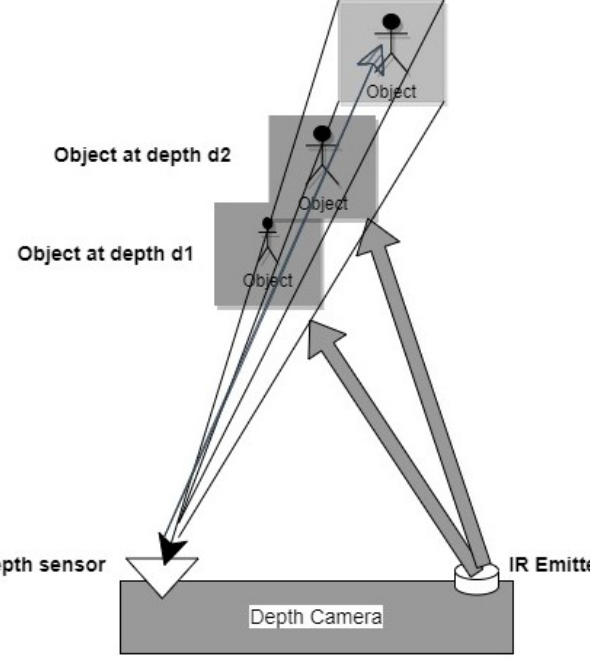
Figure 2. A working scenario of Depth